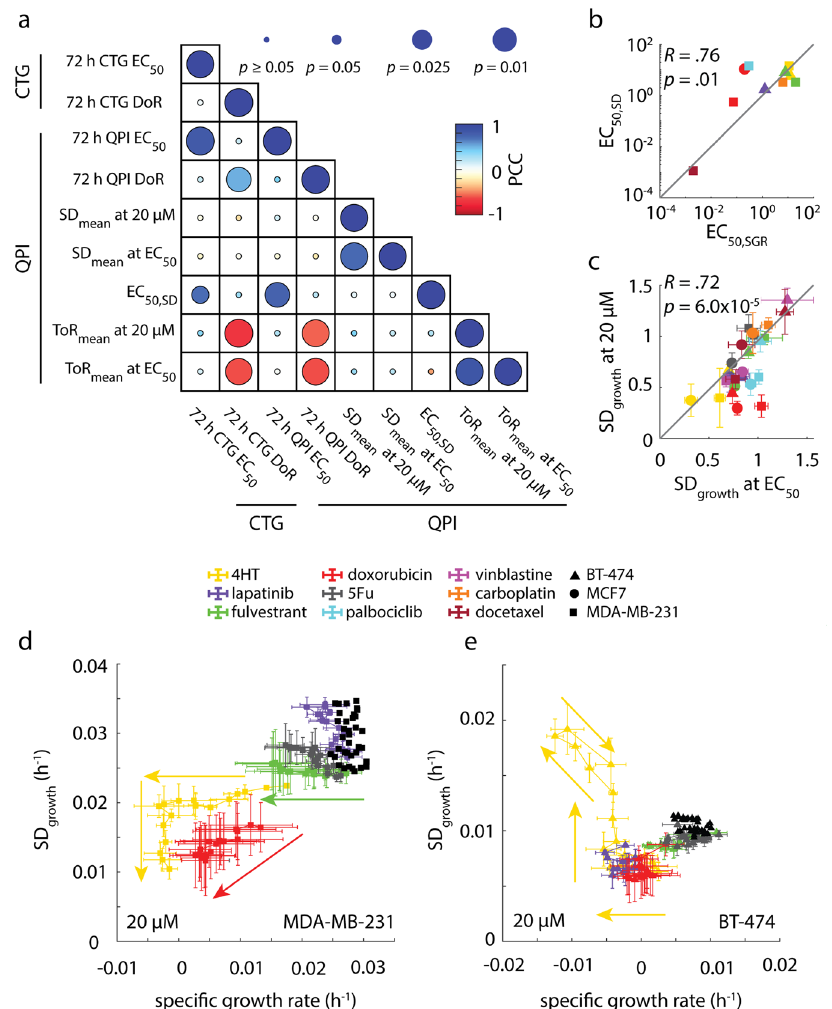
Fig. 5 QPI functionally classi fi es drugs based on how they affect cell behavior. a Correlation matrix showing how functional measurements are related and predictive of how cancer therapies affect heterogeneity. b EC 50,SD is strongly correlated with EC 50,SGR ( R = 0.76, p = 0.01) c Standard deviation in growth at 20 µ M concentration is strongly correlated with standard deviation of growth at EC 50 . d Plot of mean speci fi c growth rate plotted against standard deviation in growth parameterized by time for MDA-MB-231 cells treated with maximal concentration of drug panel A. e Plot of mean speci fi c growth rate plotted against standard deviation in growth parameterized by time for BT-474 cells treated with maximal concentration of drug panel A. Control cells for d and e are shown as a cluster of black dots. Arrows in d and e show forward direction in time. Error bars show